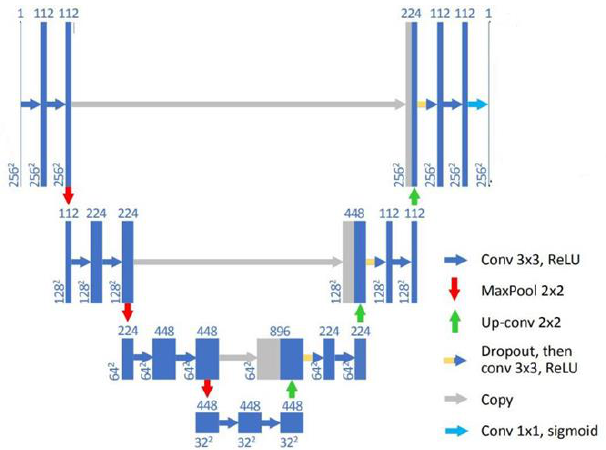
Figure 4. U-net architecture. Blue boxes denote cross-sections of sets of feature maps. For each set, the dimensions of its maps are shown on its lower left, and the number of maps are shown on its upper part. Half-grey boxes mean the sets for which half of their maps are copied. Arrows with different colors represent different operations, where blue arrows represent convolutions and gray ones represent copying (Cited and revised from [29]).